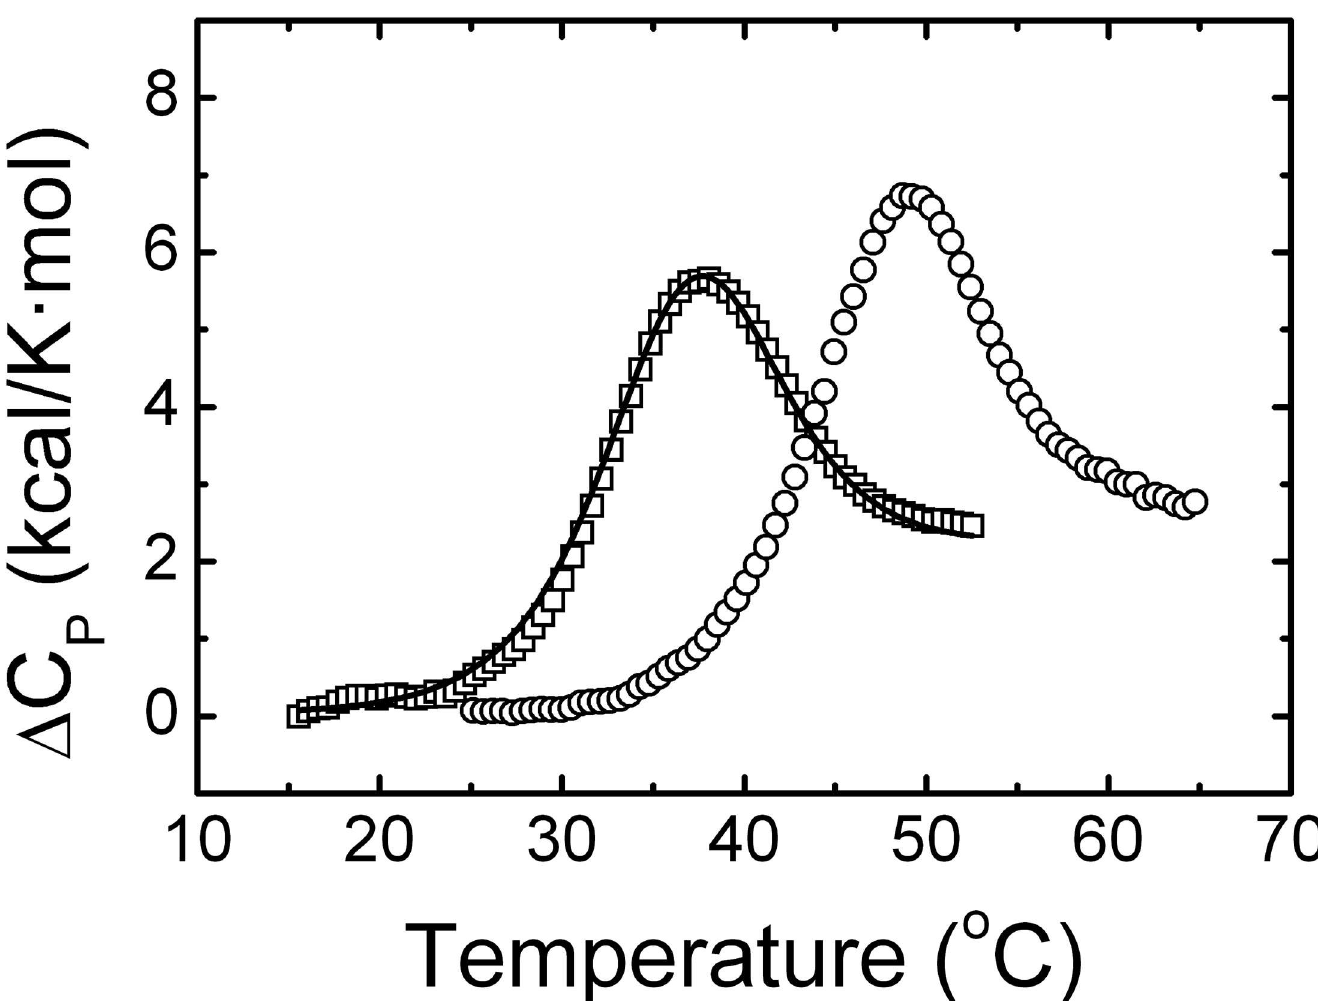
Fig 4. DSC analysis in the absence of FMN (open squares) or in the presence of 40 μ M of FMN (open circles) in 150 mM NaCl, 100 mM MES, pH 6.5. The continuousline is the non-linear fitting curve obtained by using a two-state model for the unfoldingof